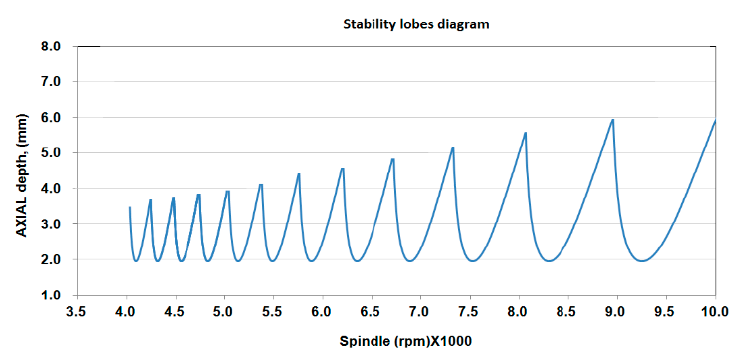
Figure 2. Frequency response function (FRF) of the milling cutter. ( a ) FRF—Dynamic compliance. ( b ) FRF—Real part.